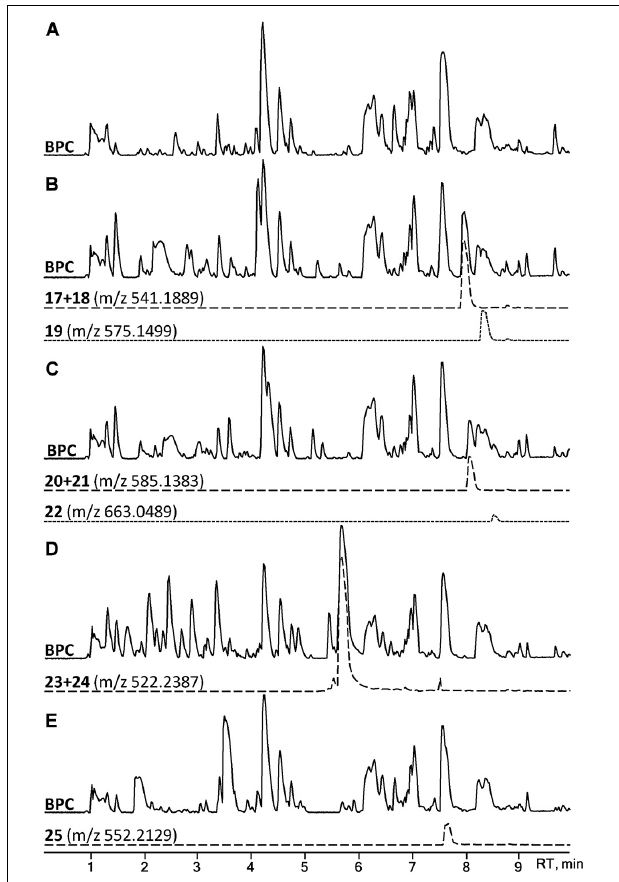
FIGURE 8 | HPLC-MS analysis for asperphenamate analog production upon para-substituted phenylalanine supplement on CZ media. BPCs of P. astrolabium extracts of (A) control and growth (B) chloro-, (C) bromo-, (D) amino-, and (E) nitro- phenylalanine supplemented media. EIC in dashed line corresponds for a single amino acid, while dotted indicates a double amino acid incorporation.